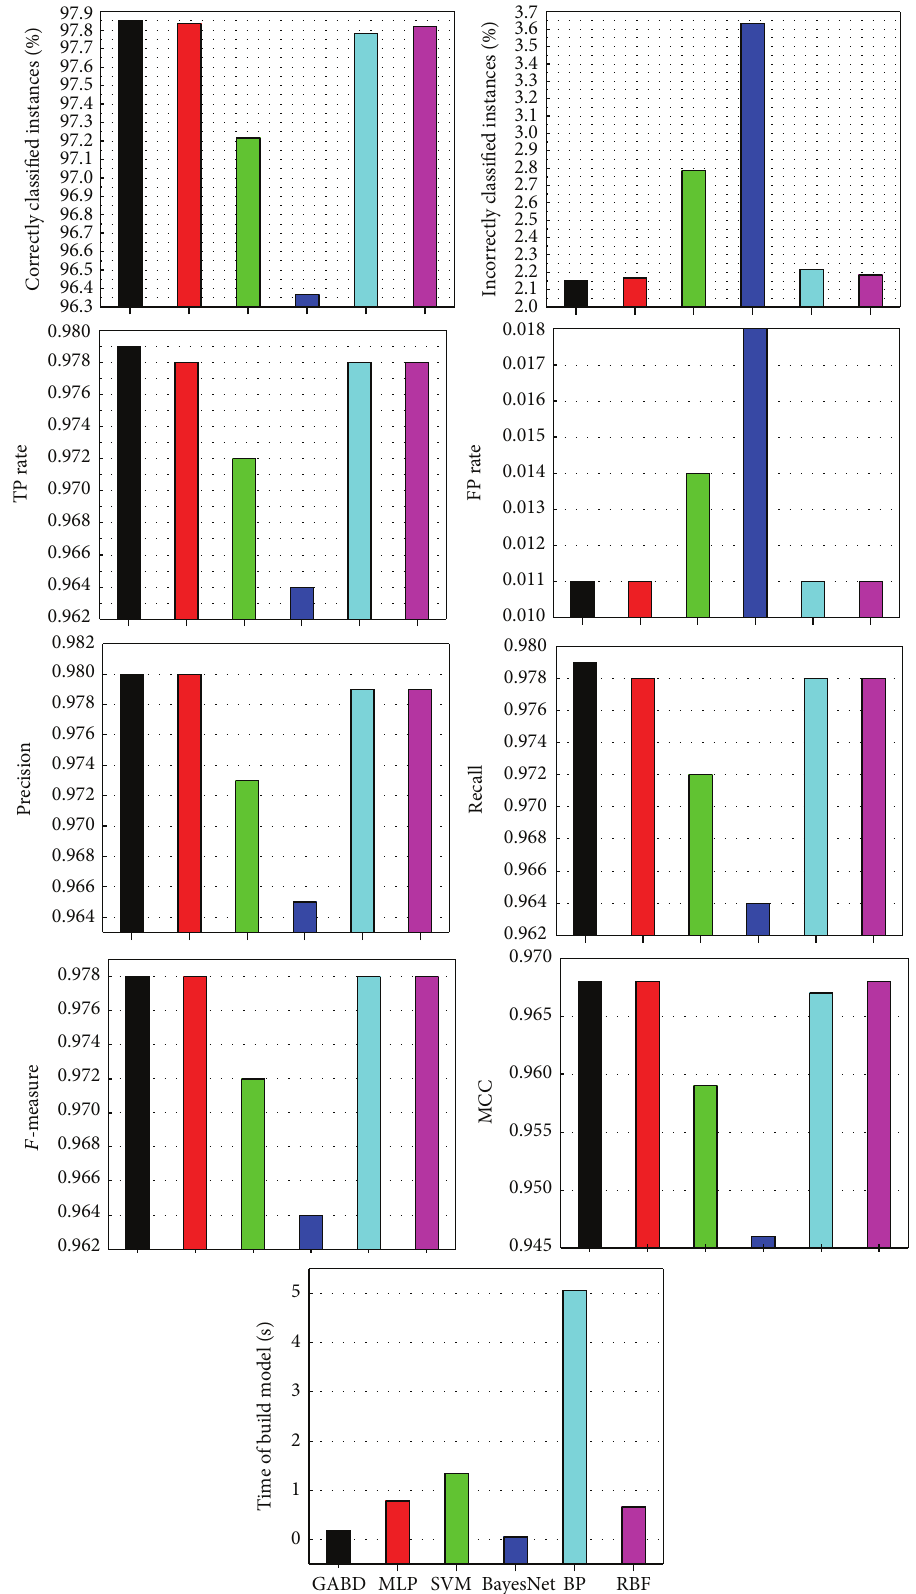
Figure 6: Comparison of classification performances between different detection